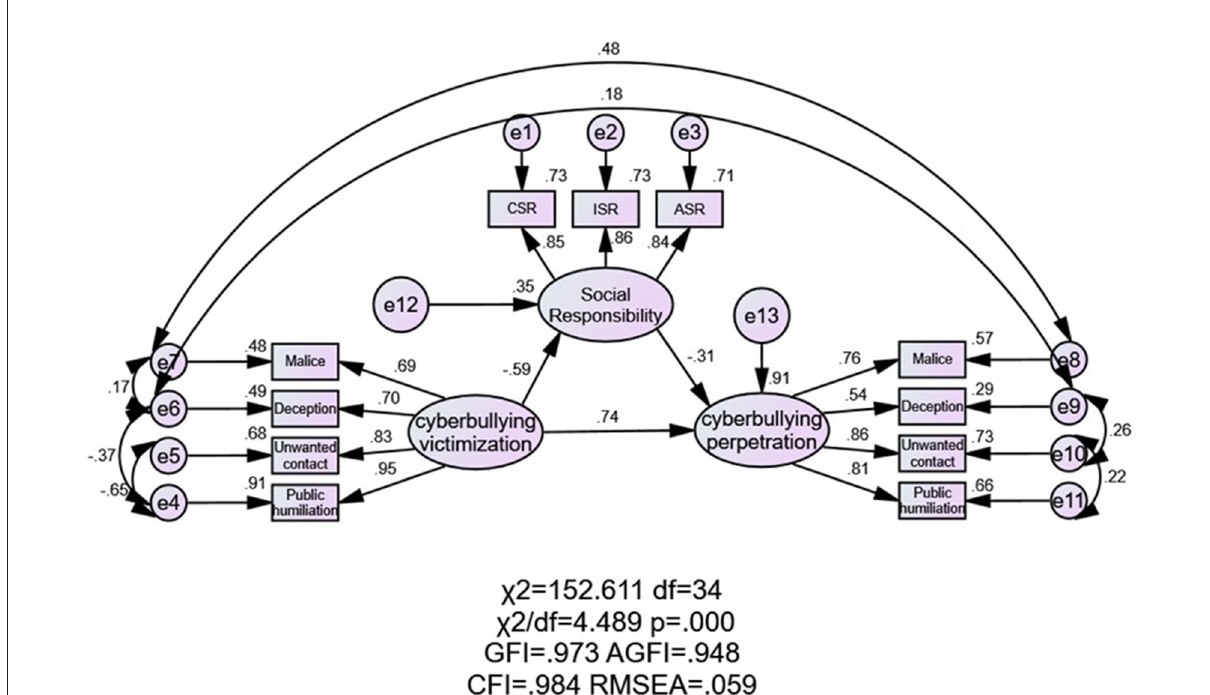
FIGURE2 The SEM of the relationship among cyberbullying victimization, cyberbullying perpetration and social responsibility. SEM, stands for structural equation model; CSR, stands for cognition of social responsibility; ISR, stands for identification of social responsibility; ASR, stands for action of social responsibility.